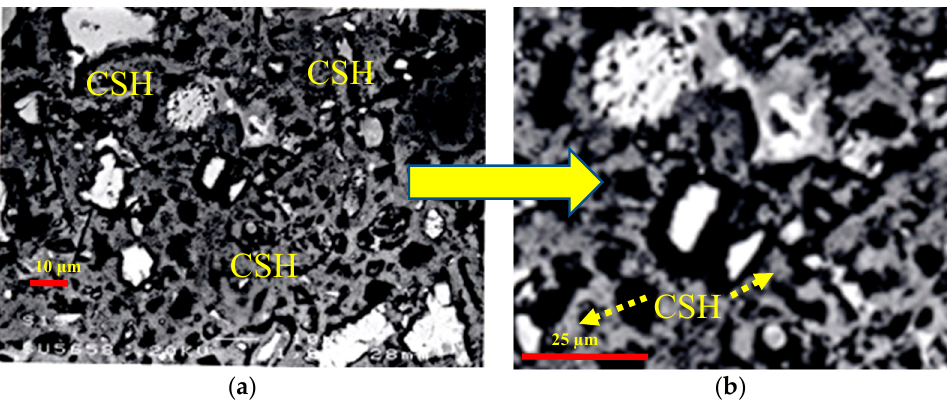
Figure 14. BSE of PC-SF binary mixture containing ( a ) 15% SF, ( b ) 2.5× enlarged spot showing CSH.